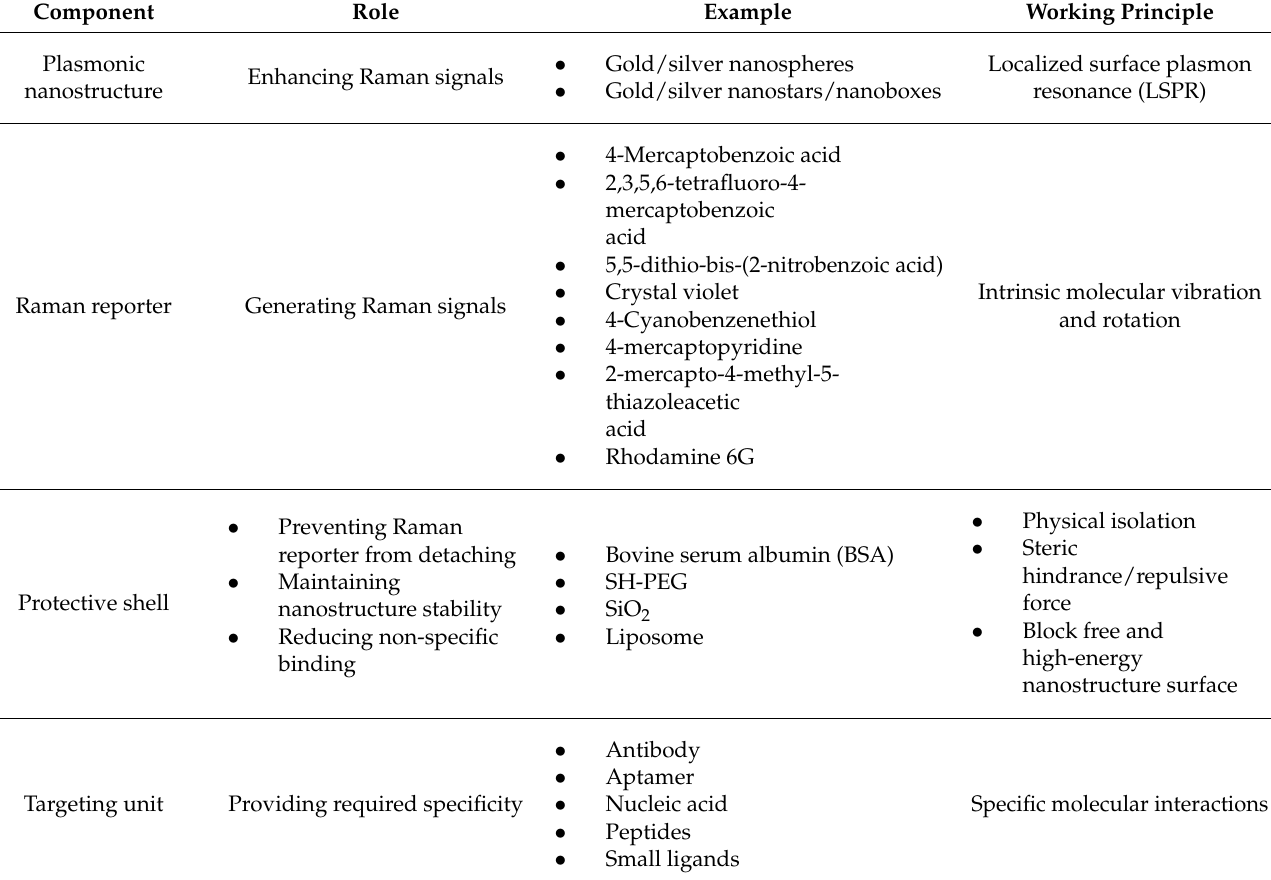
Figure 2. SERS principle of using plasmonic nanostructure to enhance the Raman reporter signals. Table 1. Typical components of functional SERS